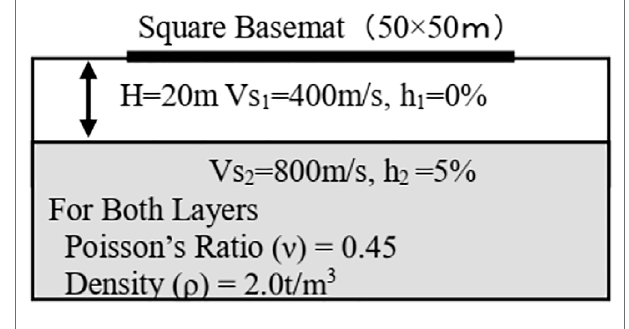
FIGURE 2 | Soil properties for No.